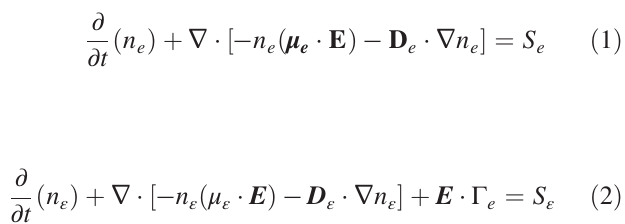
Figure 6 indicates the calculated volume reaction rate coefficients σ ð ε Þ , where T represents the electron temper- ature and ion temperature for electron reactions and heavy particulate reactions, respectively. In addition, the rate coefficients of the heavy particle reactions are compared to the target particles.